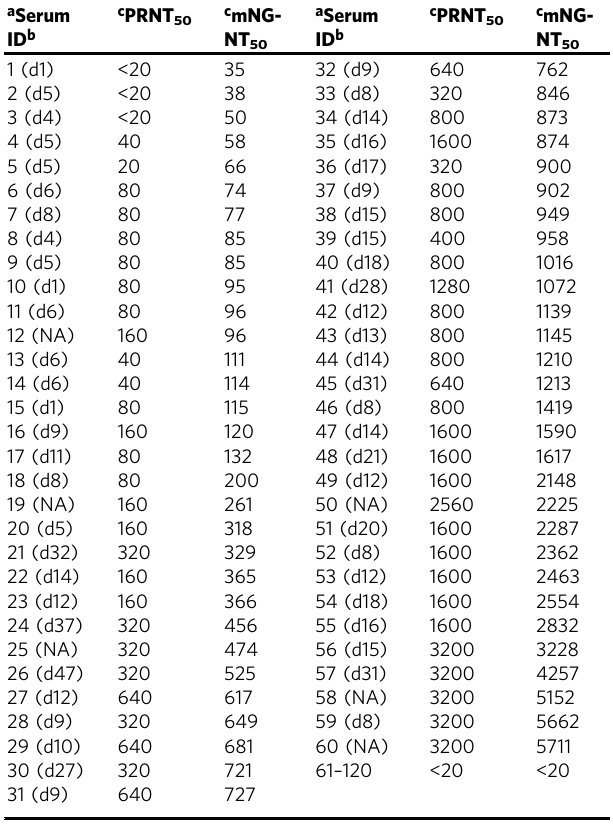
Table 2 Cross reactivity of mNG SARS-CoV-2 neutralization assay.